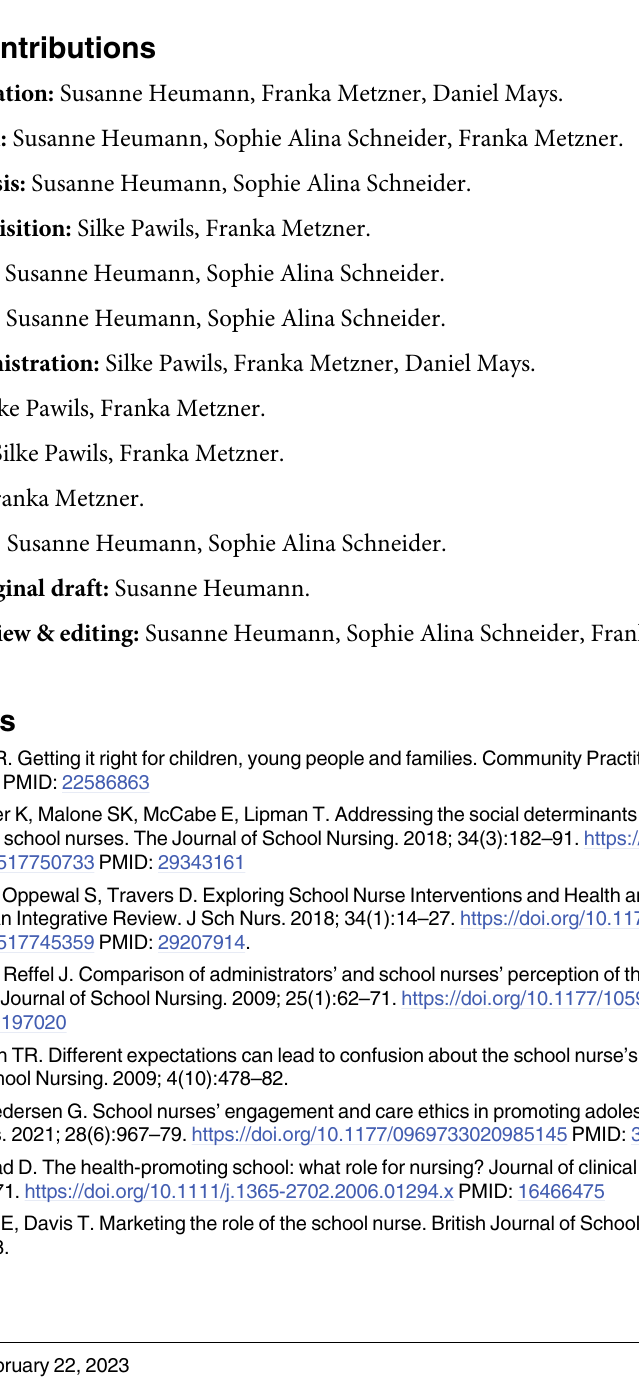
S1 Table. All identified primary studies (j = 352). S2 Table. Characteristics of primary studies (k = 289)